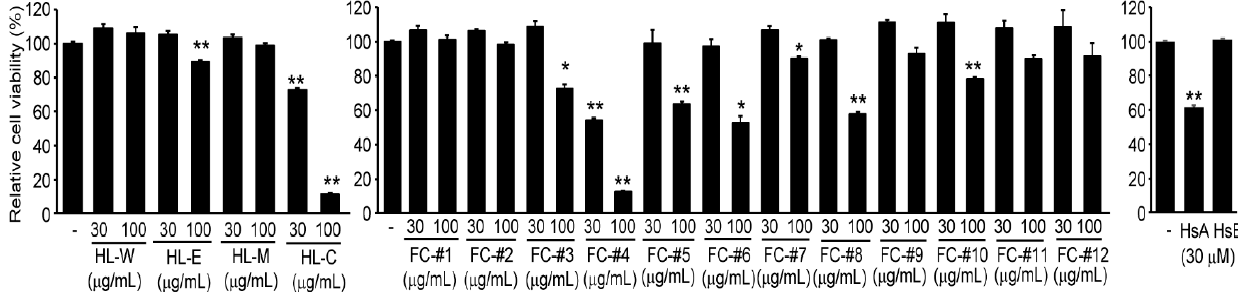
Figure 1. Effects of H. lyrata crude extracts or isolated bioactive compounds on the viability of HepG2 cells. After HpeG2 cells were treated with four H. lyrata crude extracts (left), twelve fractionated H. lyrata chloroform extracts (middle), HsA, or HsB (right) for 24 h, relative cell viability was determined by thiazolyl blue tetrazolium bromide (MTT) assay. ** p < 0.01, * p < 0.05, significance versus vehicle-treated cells: HL-W, H. lyrata water extract; HL-E, H. lyrata ethanol extract; HL-M, H. lyrata methanol extract; HL-C, H. lyrata chloroform extract; FC, fractionated H. lyrata chloroform extract.